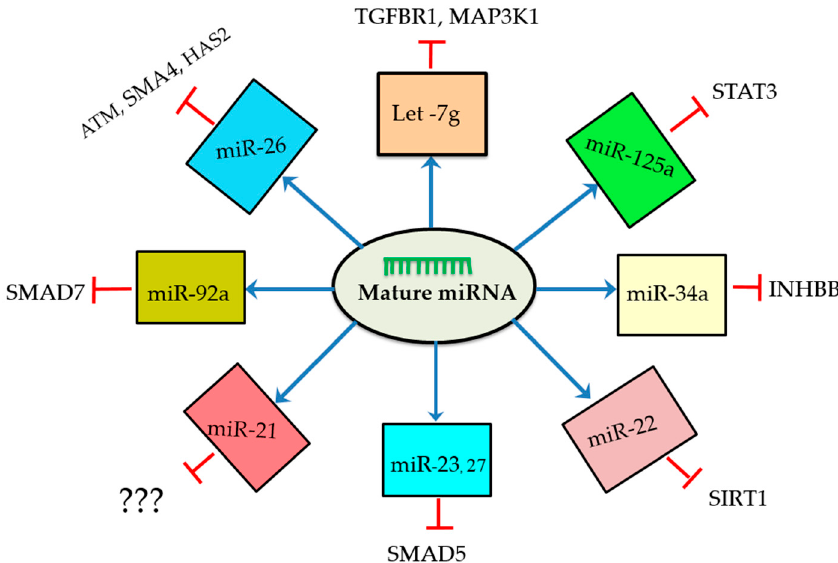
Figure 3. Schematic representation of miRNAs along with their target genes. These miRNAs regulate granulosa cell apoptosis through involving different signaling pathways by negatively regulating their target genes. Mature miRNAs are generated from transcribed miRNA genes and sorted to different signaling pathways and guided to regulate their respective target genes.